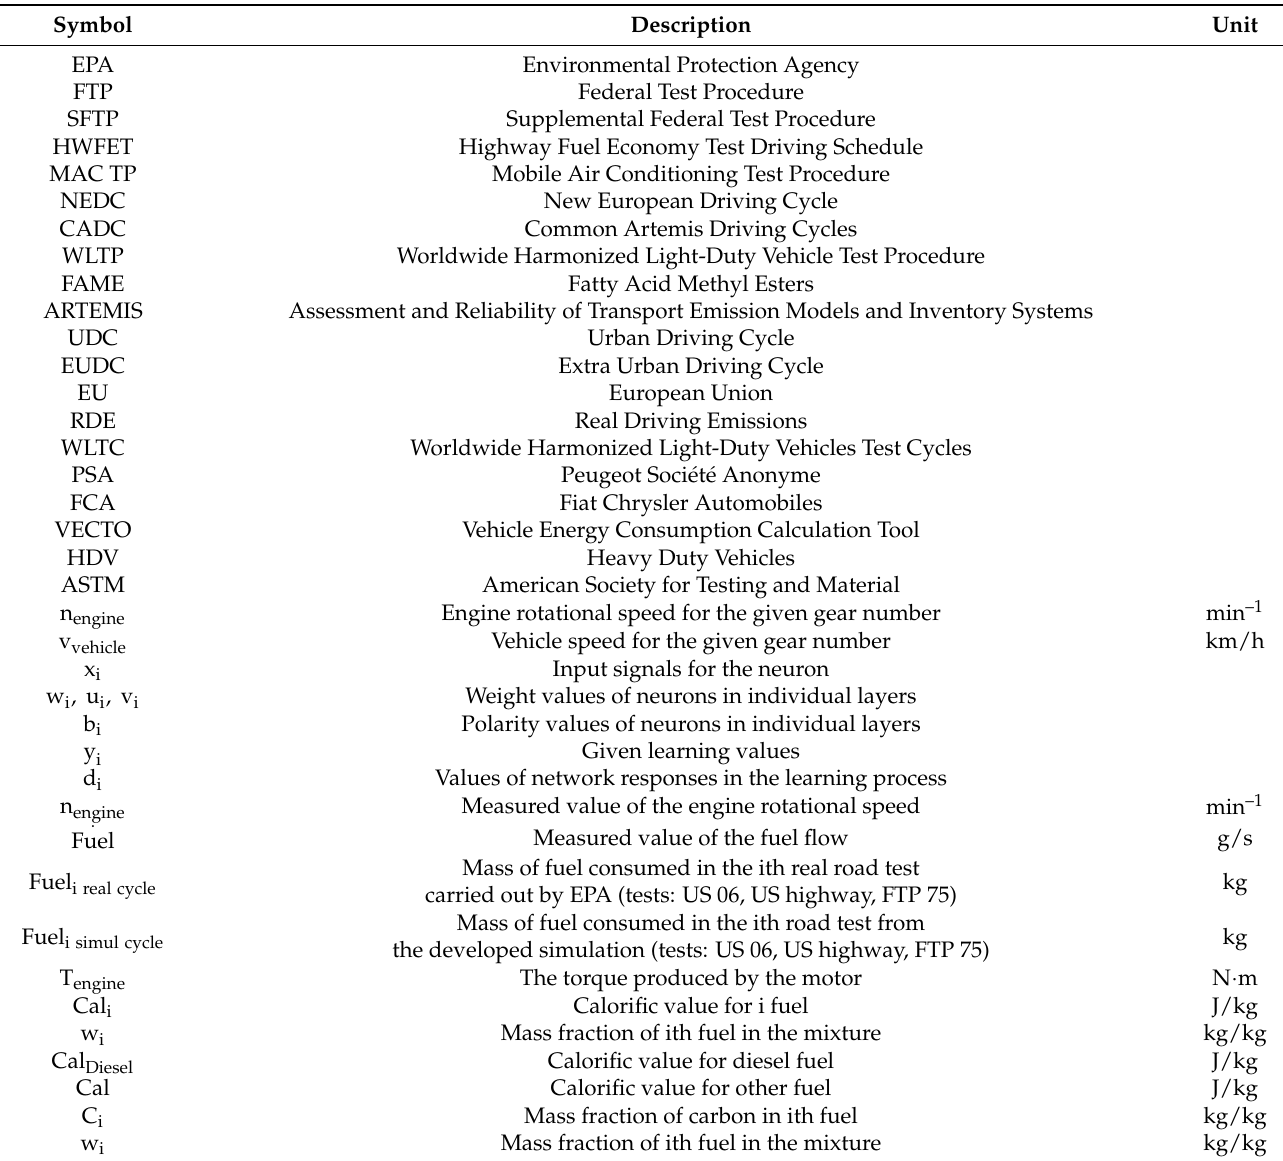
Table 1. Abbreviations, symbols and units used in the